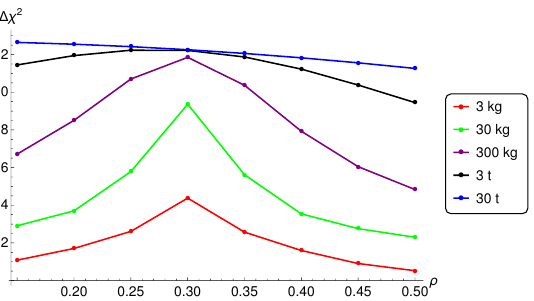
Figure 6 . (cid:1) (cid:31) 2 as a function of the average chemical composition of the far detector spectrum, for di(cid:11)erent near detector mass. The peak at (cid:26) = 0 : 3 results from the fact that the time-averaged unoscillated spectra at the near and far detectors are